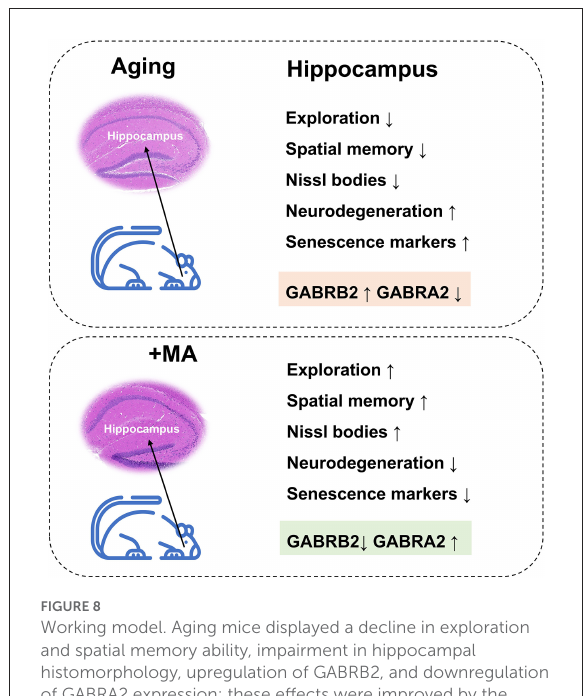
FIGURE8 Working model. Aging mice displayed a decline in exploration and spatial memory ability, impairment in hippocampal histomorphology, upregulation of GABRB2, and downregulation of GABRA2 expression; these effects were improved by the administration of